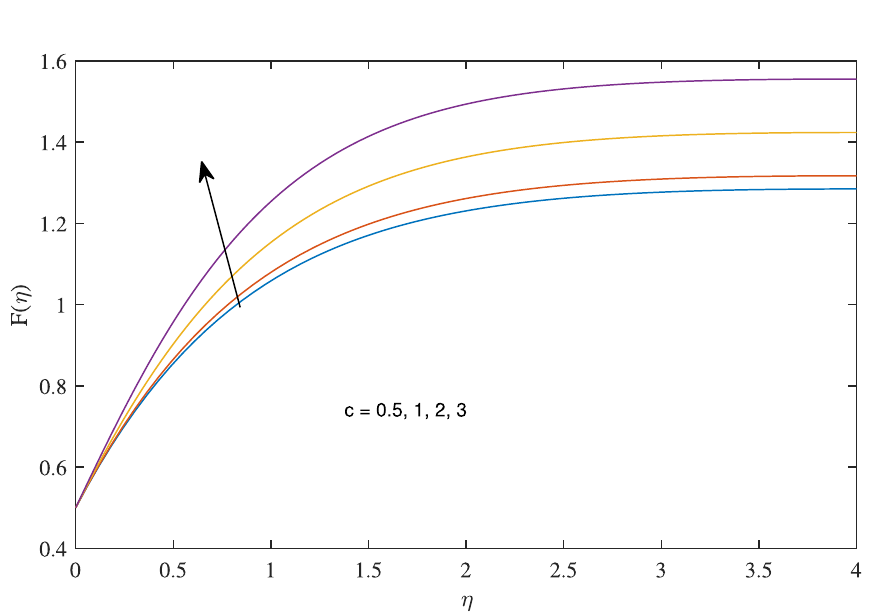
0.1 , β 0.1 and 0.5 , ζ 0.2 , N 1 , φ rd = = = = ◦ =